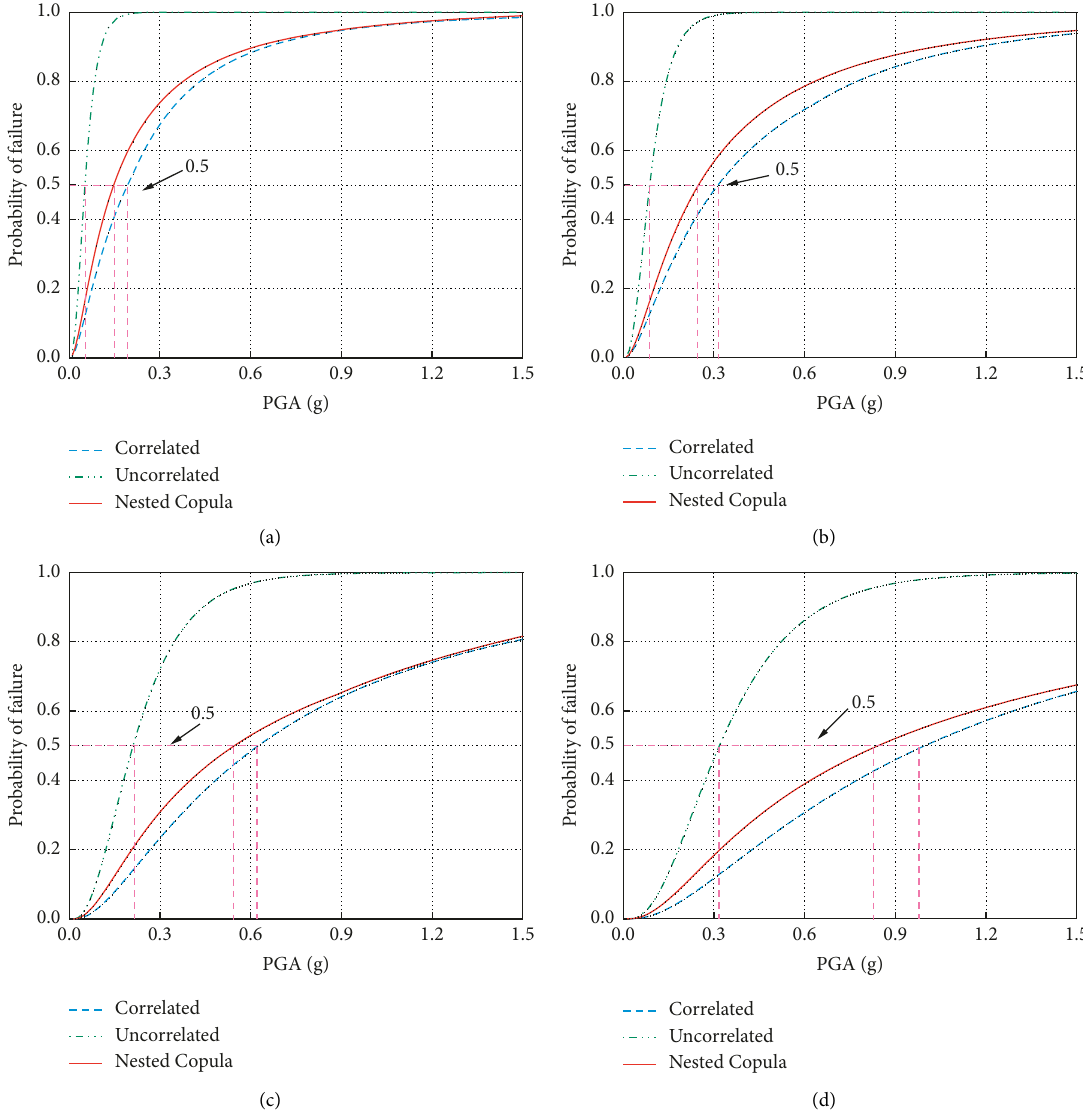
Figure 10: Overall seismic vulnerability curves of the bridge system: (a) slight damage; (b) moderate damage; (c) serious damage; and (d) complete